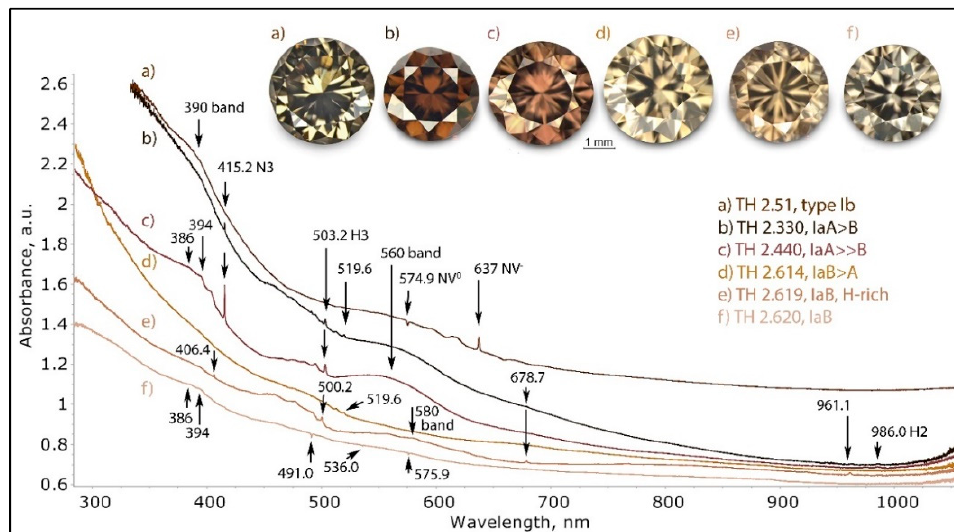
Figure 12. The range of UV-Vis-NIR spectra of type I brown diamonds with a plastic deformation-related color is shown in this graph. The brown color itself originates in all cases mainly from the continuum absorption that is relatively flat and steadily increasing from the NIR to UV. Since the indexed overlaying absorptions are all comparatively weak, they have only a limited influence on the color. A notable exception is the 560 nm band, which causes a pink hue added to the brown. The spectra were shifted vertically for clarity.